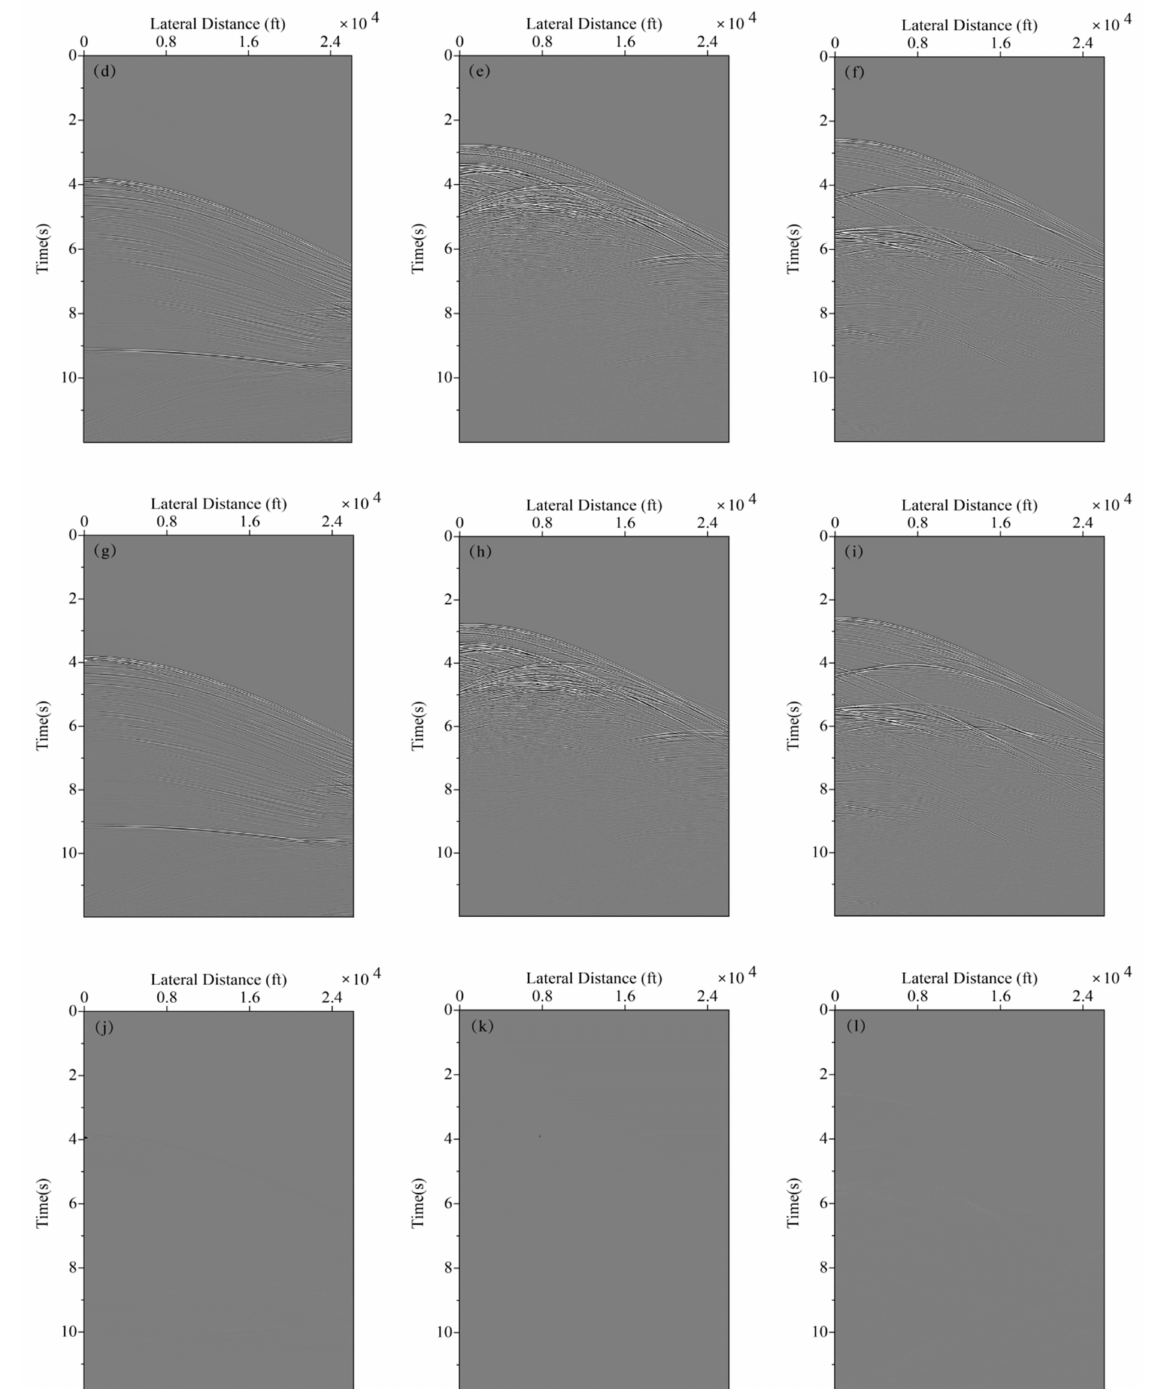
Figure 7. Shot record with surface-related multiple elimination using deep learning. ( a ) The 10th shot record with surface-related multiples. ( b ) The 150th shot record with surface-related multiples. ( c ) The 310th shot record with surface-related multiples. ( d ) The 10th shot record without surface-related multiples. ( e ) The 150th shot record without surface-related multiples. ( f ) 310th shot record without surface-related multiples. ( g ) The 10th shot record without surface-related multiple elimination using deep learning. ( h ) The 150th shot record without surface-related multiple elimination using deep learning. ( i ) The 310th shot record without surface-related multiple elimination using deep learning. ( j ) The difference between ( d ) and ( g ). ( k ) The difference between ( e ) and ( h ). ( l ) The difference between ( f ) and ( i